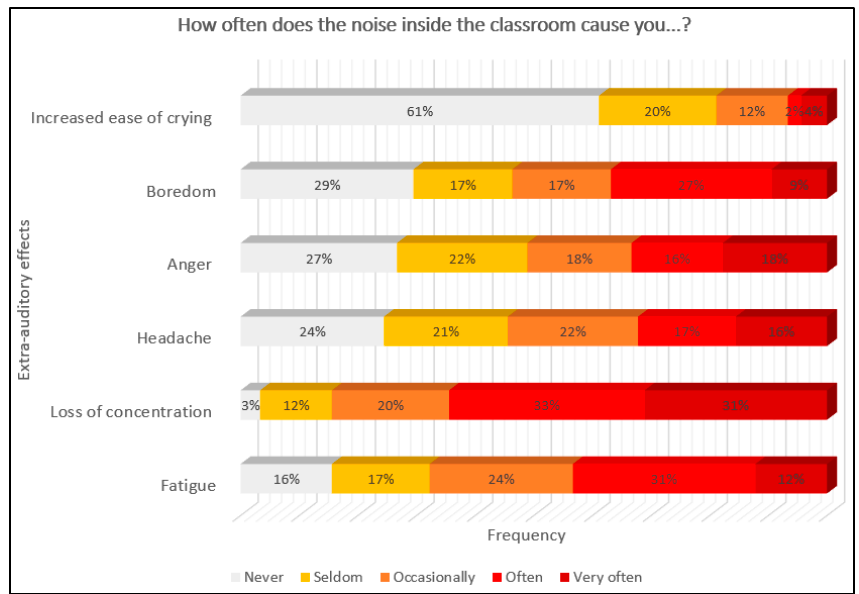
Figure 8. Answers to the question “How often does the noise inside the classroom cause you an increased ease of crying/boredom/anger/headache/loss of concentration/fatigue?” from Question- naire 1, administered to students. The figure shows the frequency of occurrence of extra-auditory effects due to noise exposure in the classroom